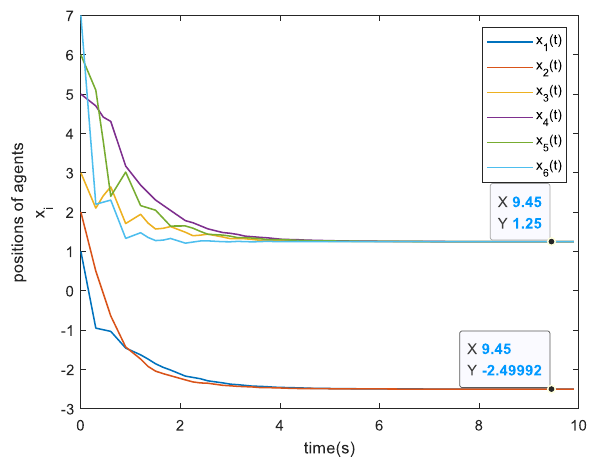
Figure 5. Event times for each agent.